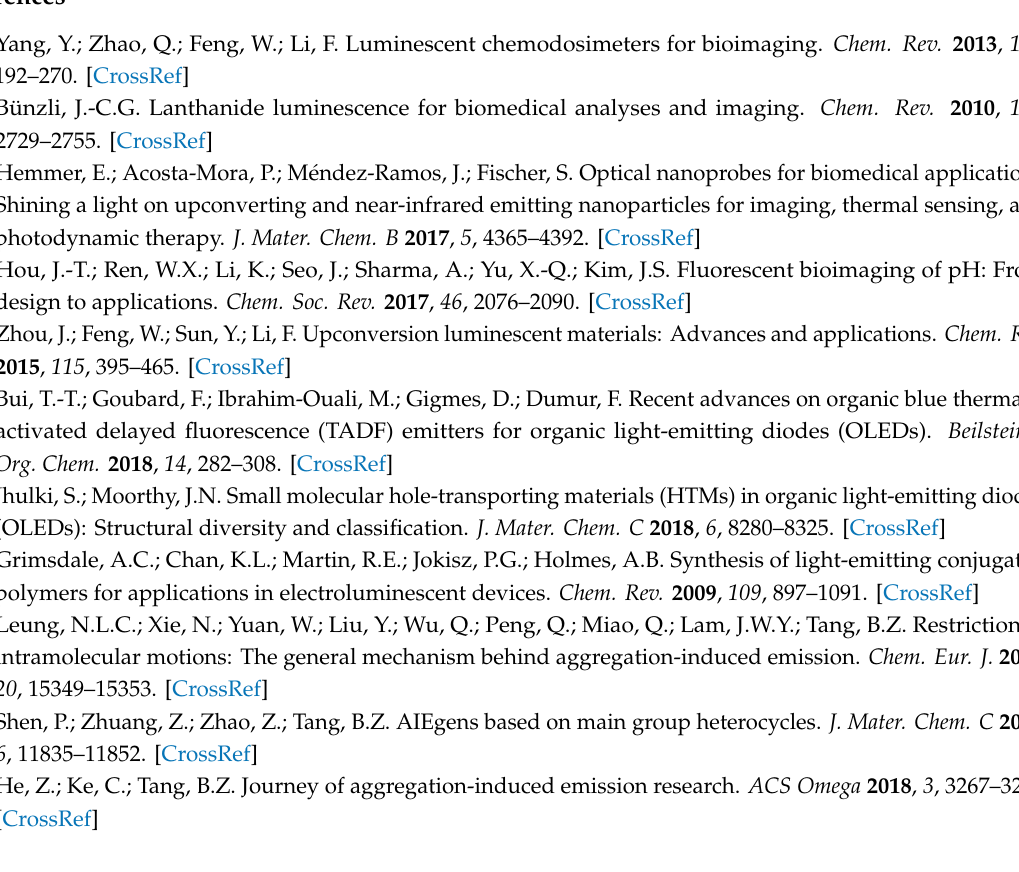
Figures S1–S18: NMR spectra, Table S1: crystallographic data, Figure S19: DSC thermograms, Tables S2–S6: phase transition behavior and thermodynamic parameter, Figure S20: photophysical spectra in solution, Figure S21: comparison between calculated and experimental UV-vis spectra, Figure S22: photophysical spectra in crystal, Figure S23: PL spectra in LC phases, Figures S24–S34: HOMO and LUMO diagram, Tables S7–S18: cartesian coordinate for calculated